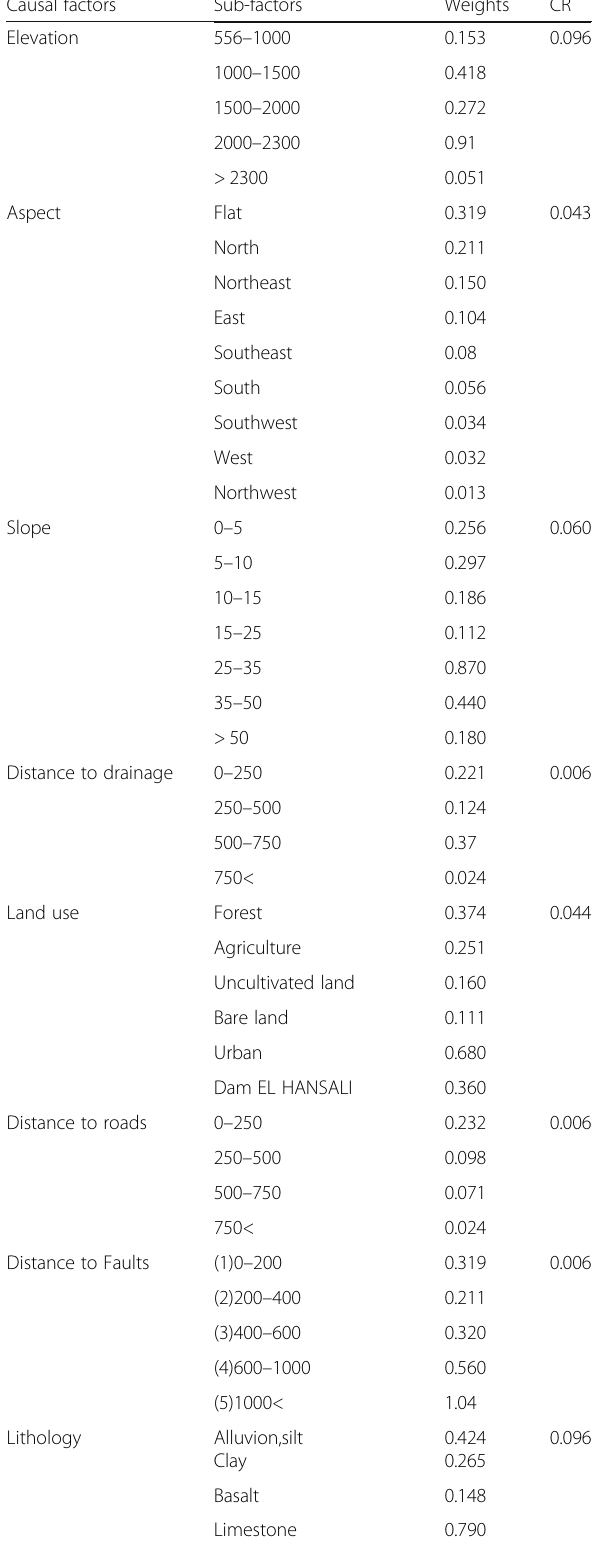
Table 4 Weights of sub-factors using AHP pairwise matrix